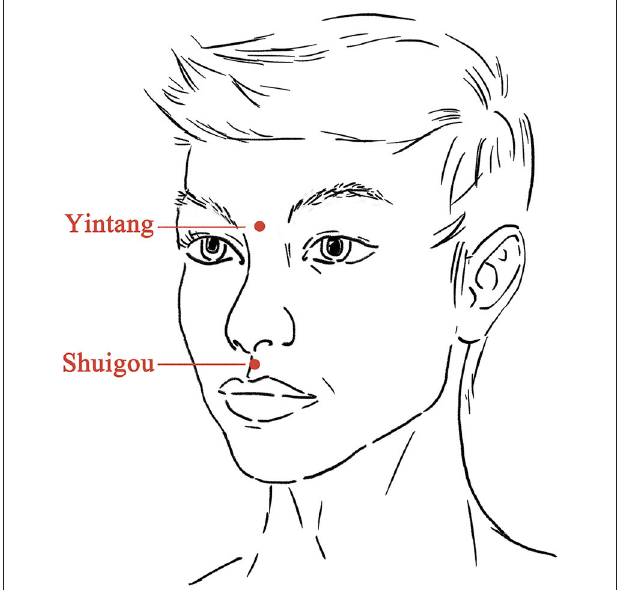
FIGURE 2 | Location of acupoints for the